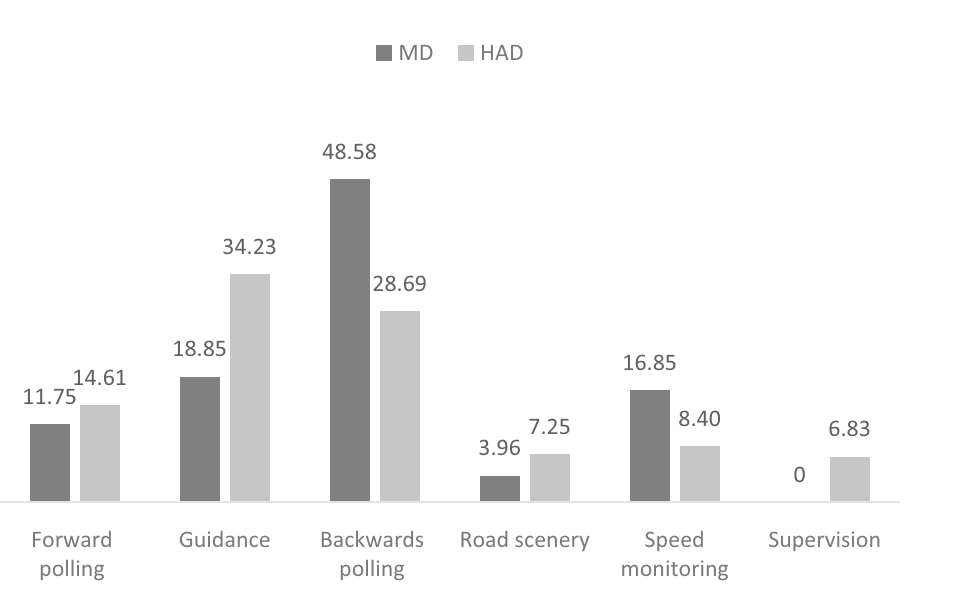
Figure 5. Percentage of scan paths of length 4 in the different visual sequence classes under Manual Driving (MD) and Highly Automated Driving